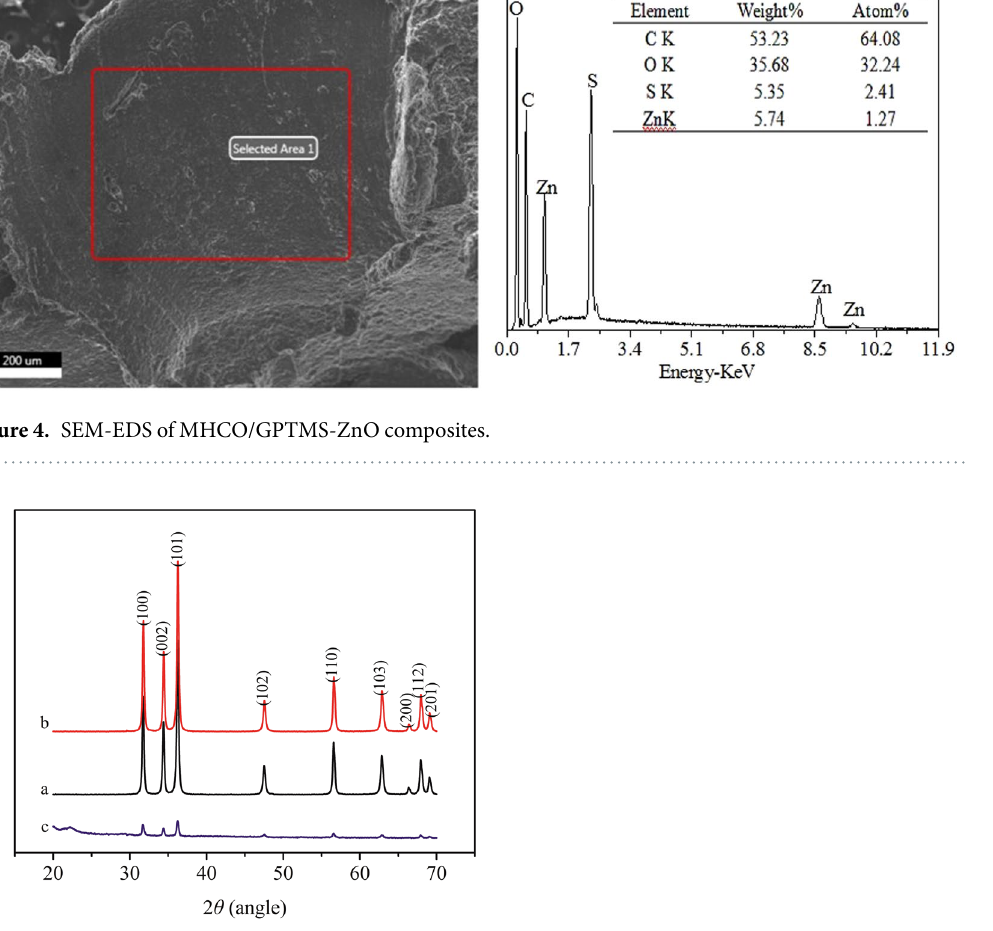
Figure 5. XRD patterns of ( a ) bare ZnO, ( b ) GPTMS-ZnO and ( c )